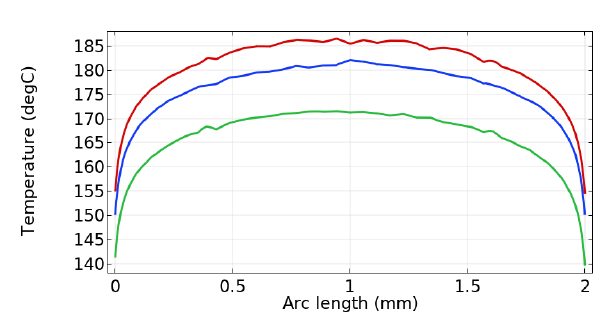
FIGURE 12. Temperature of the Horizontal (blue) and Vertical (green, red) Solid State Amplifiers. Of course, if needed the cold plate can be placed at bottom surface of the heat sink as well, resulting in equal temperature for bottom and top MMICs.